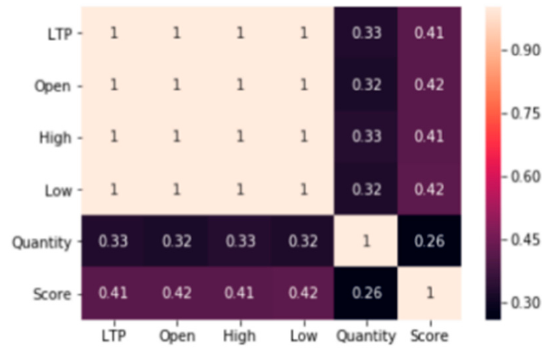
Figure 3. Correlation matrix between all features.